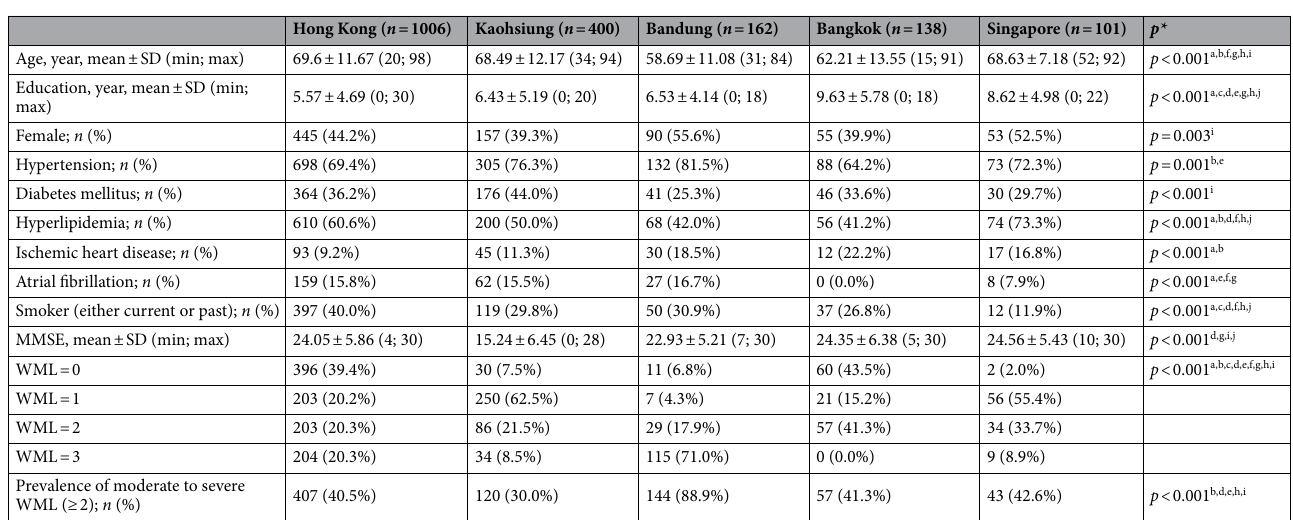
Table 2. Clinical demographics of the stroke/TIA group. This table showed the clinical demographics of the stroke/TIA group. a Hong Kong versus Bangkok. b Hong Kong versus Bandung. c Hong Kong versus